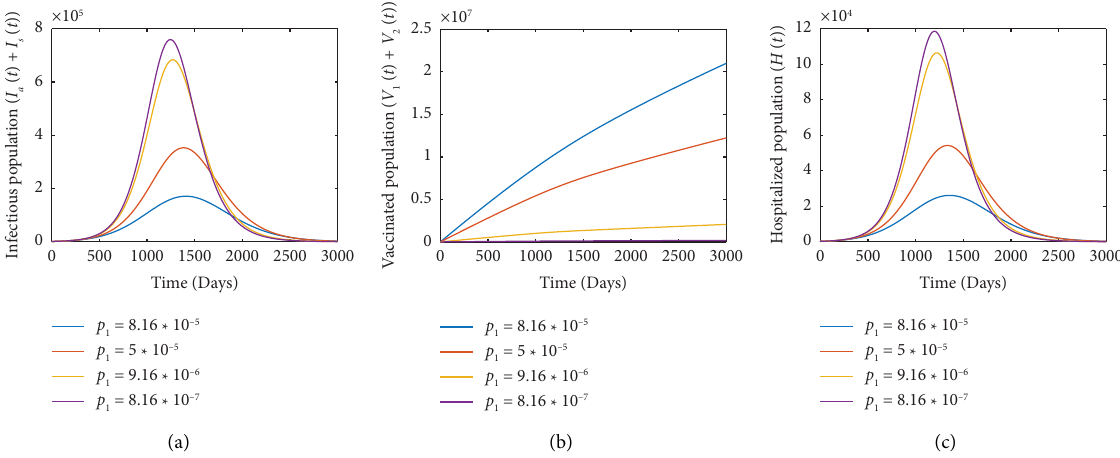
Figure 8: Te impact of the frst dose vaccination rate p hospitalized population (c) Other parameter values are given in Table 2.